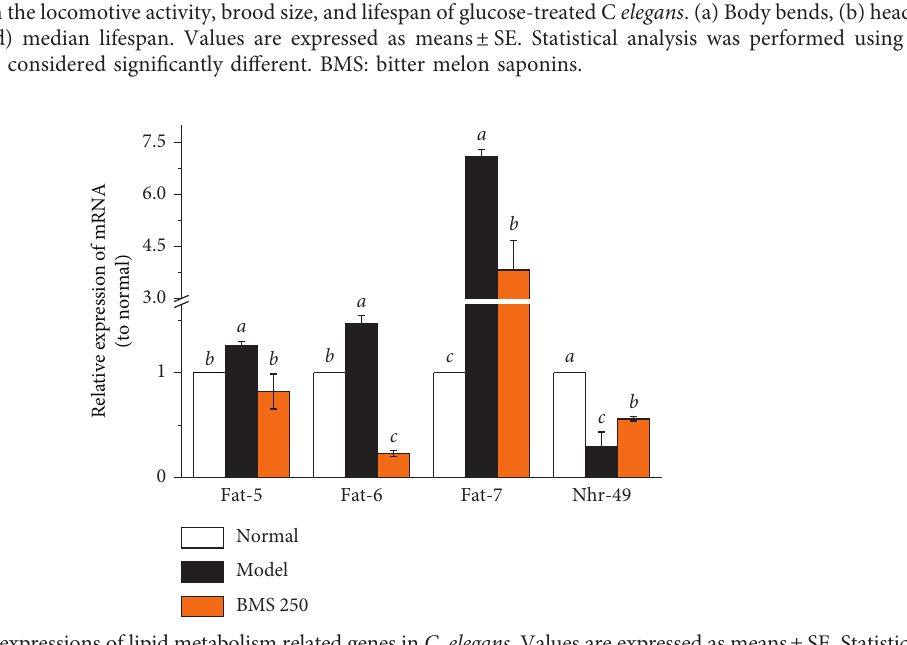
Figure 6: Effect of BMS on expressions of lipid metabolism related genes in C. elegans. Values are expressed as means ± SE. Statistical analysis was performed using ANOVA. The means with different superscript were considered significantly different. BMS: bitter melon